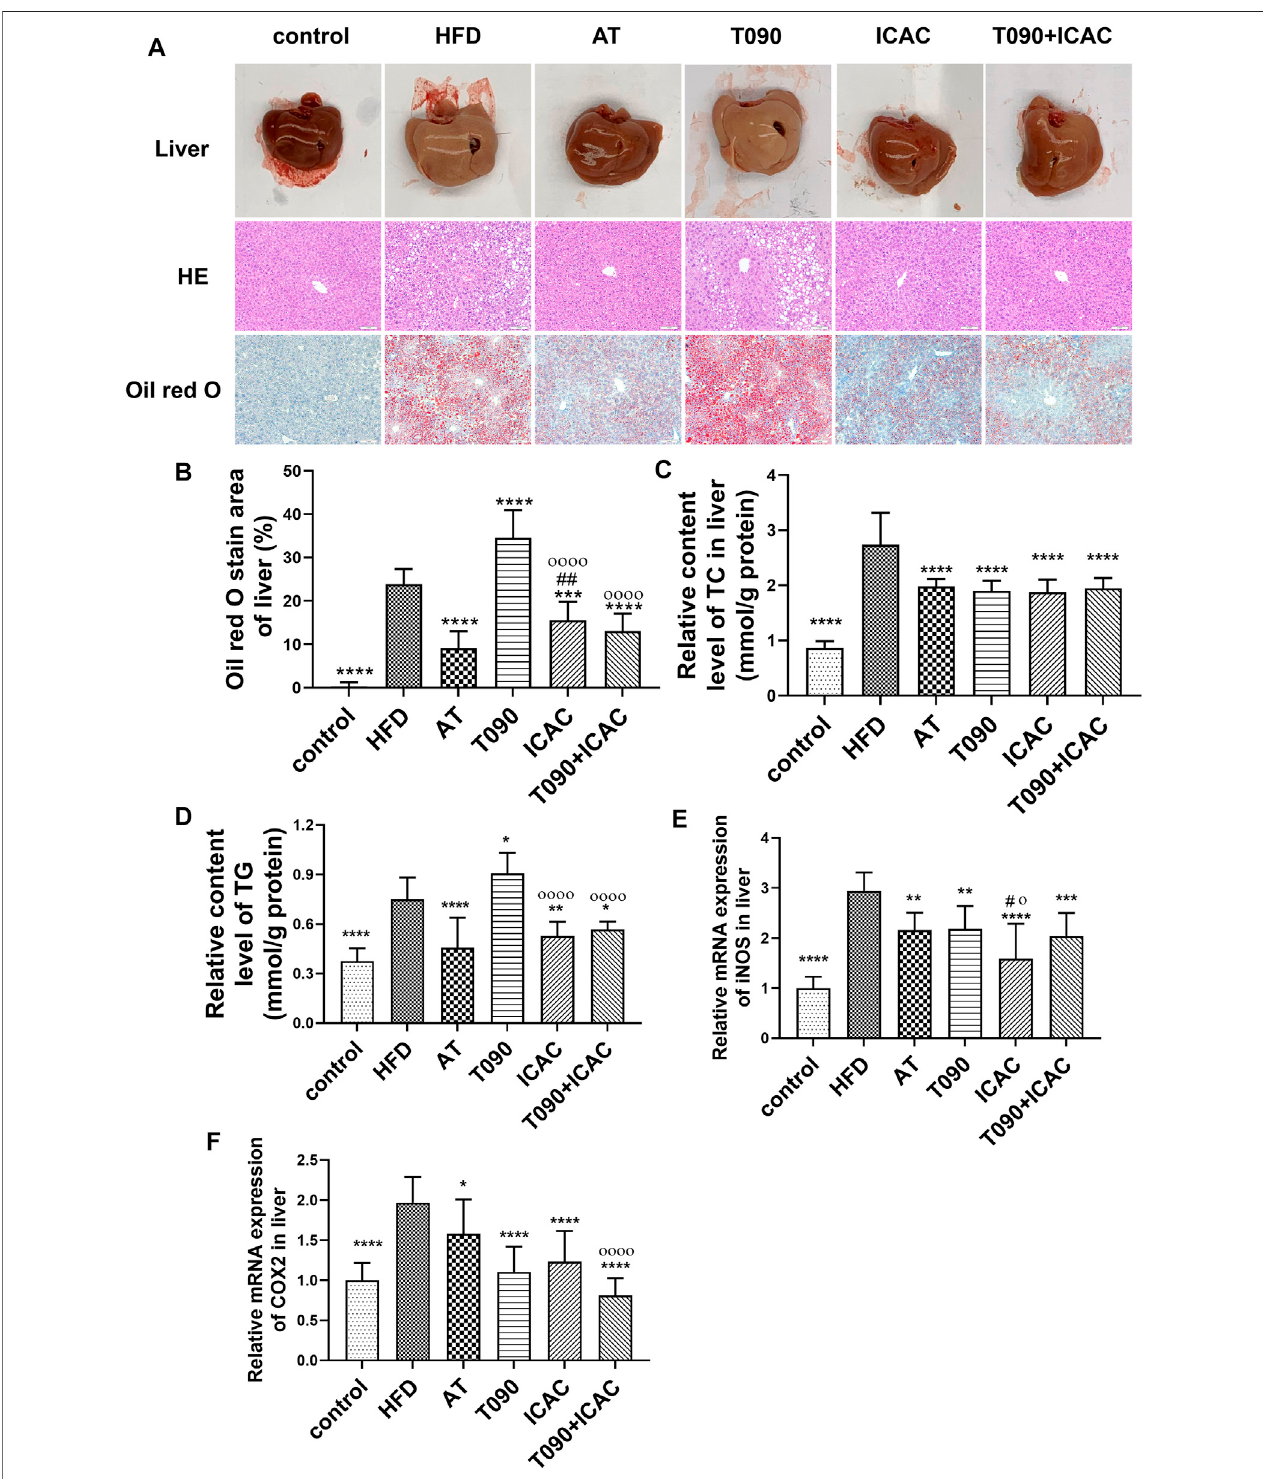
FIGURE 4 | ICAC decreases hepatic tissue lipid and in fl ammation levels in HFD-induced hyperlipidemic mice. (A) Liver morphological investigation, HE and ORO stainingofliverbiopsy. (B – F) OROstainingarea,TC,TGlevelandthegeneexpressionlevelsofiNOSandCOX2inliverofC57BL/6micefedachowdietorahighfatdiet with or without AT, T0901317 or ICAC for 12 weeks. All data in (B – F) were represented mean ± SEM. Statistical difference was determined by one -way ANOVA test. ComparedwithHFD,* p < 0.05,** p < 0.01,*** p < 0.001,**** p < 0.0001.ComparedwithAT, # p < 0.05, ## p < 0.01.ComparedwithT090, o p < 0.05, oooo p < 0.0001. n = 10 for each